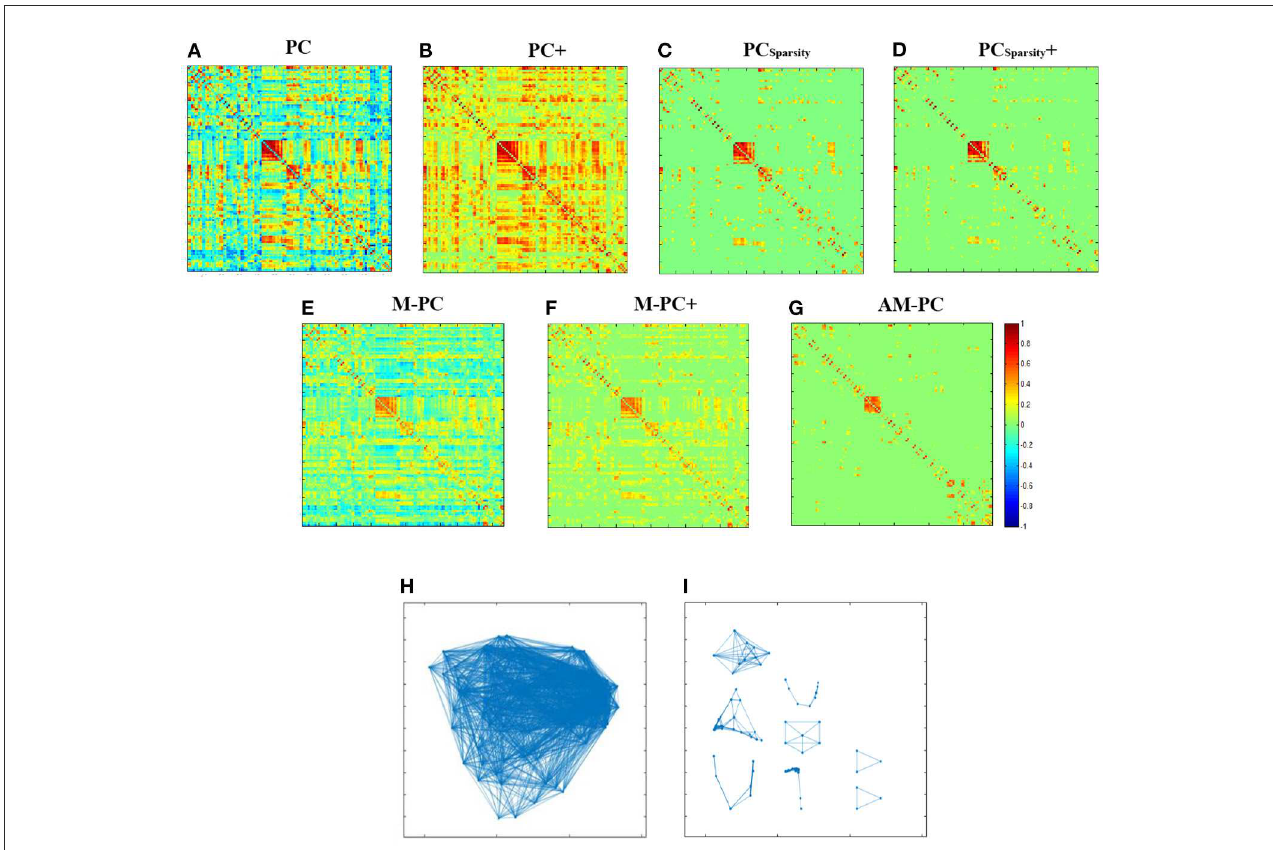
FIGURE3 Seven edge weight matrices of the same subject estimated by seven different methods, i.e., (A) PC, (B) PC+, (C) PC Sparsity , (D) PC Sparsity +, (E) M-PC, (F) M-PC+, and (G) AM-PC. (H, I) show the modules in the networks estimated by M-PC and the proposed AM-PC methods.